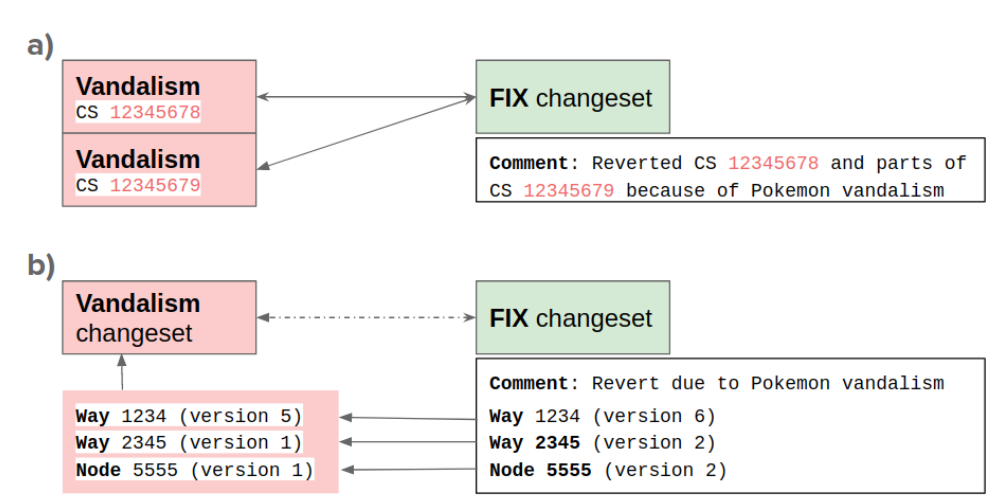
Figure 2. Identifying links between vandalism and fix; ( a ) through regex search, and ( b ) through extracting changesets from feature